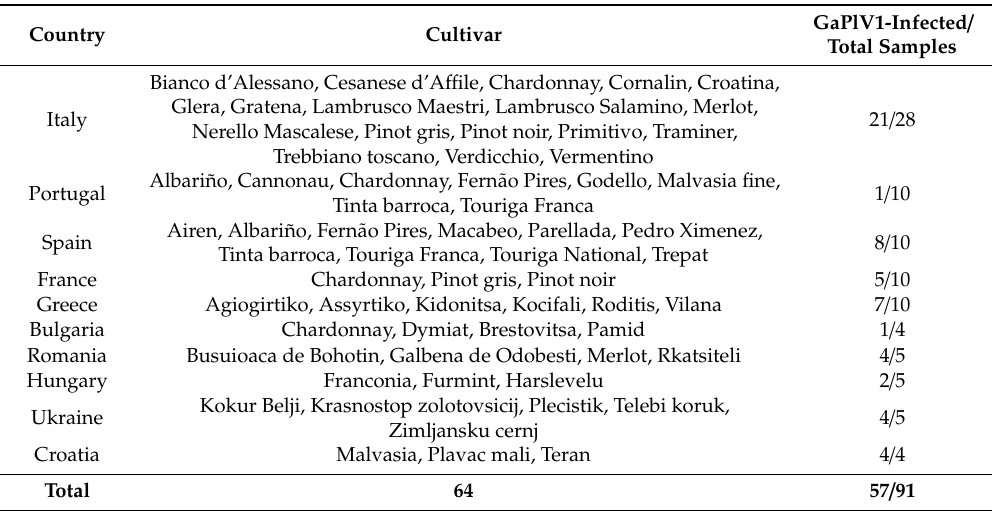
Table 1. Detection of GaPlV1 by qRT-PCR in di ff erent grapevine cultivars collected in 2012–2019 from several European countries. The number of GaPlV1-infected plants out of the total number of plants is reported for each